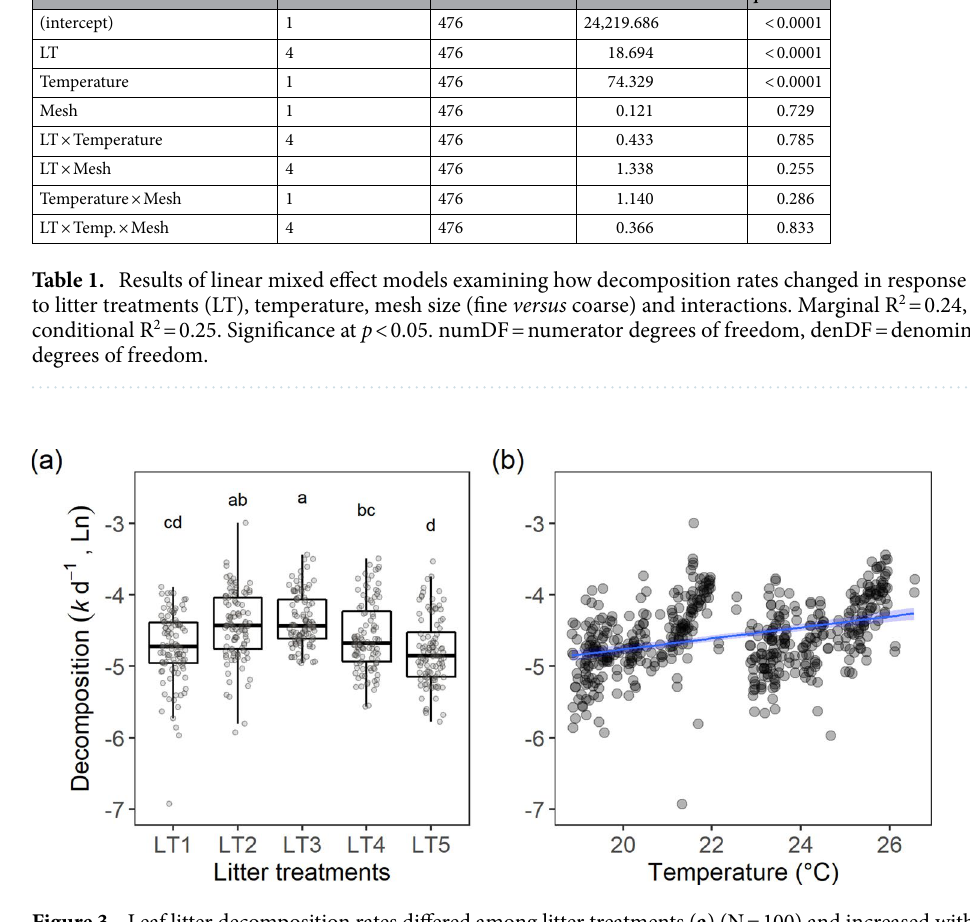
Figure 3. Leaf litter decomposition rates differed among litter treatments ( a ) (N = 100) and increased with temperature ( b ) (r = 0.35, p < 0.0001, N = 500). Different letters in ( a ) indicate statistical difference in p < 0.05. See definition of LTs in Fig. 1. Points represent data from both fine- and coarse mesh